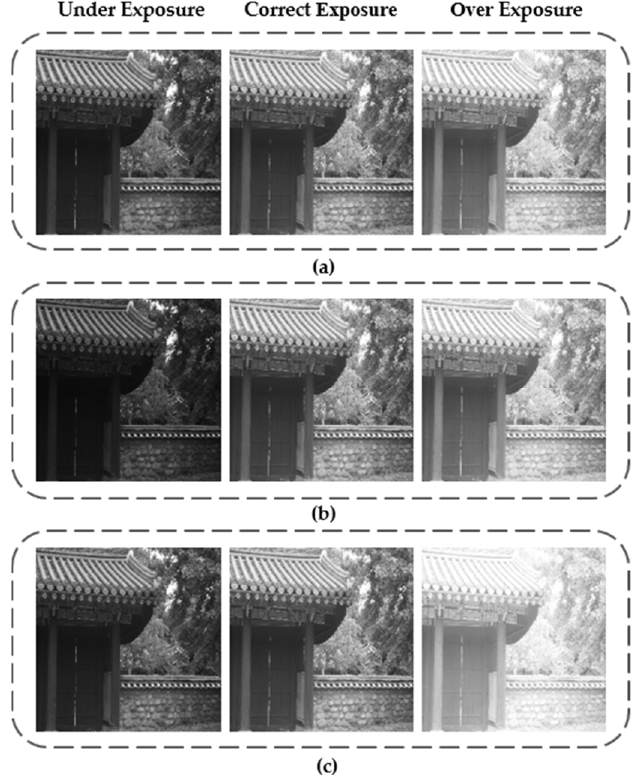
Figure 7. Image pairs by different multi-exposed images (left–right): ( a ) − 1 EV, 0 EV, and +1 EV; ( b ) − 2 EV, 0 EV, and +1 EV; ( c ) − 1 EV, 0 EV, and +2 EV.